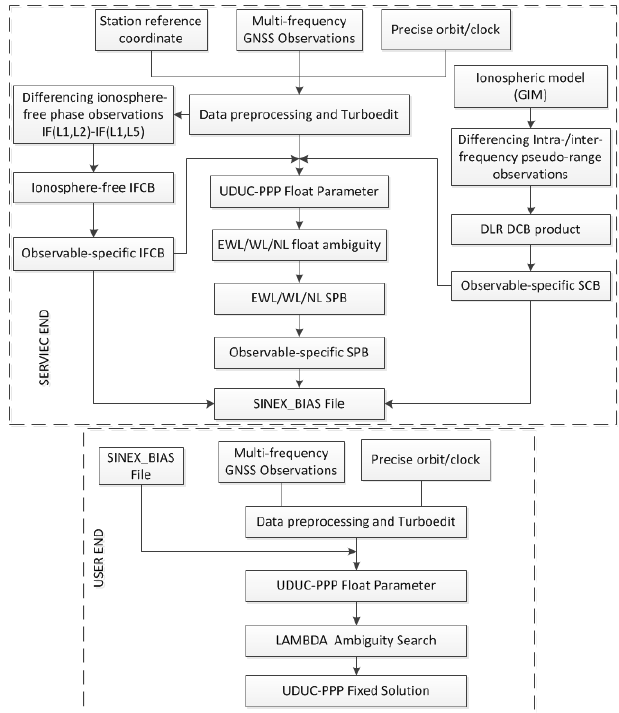
Figure 1. Flowchart of formation of observable-specific satellite code and phase biases at the service end and observable-specific bias corrections for multi-frequency UDUC-PPP AR at the user end. 3.Experiment and Results